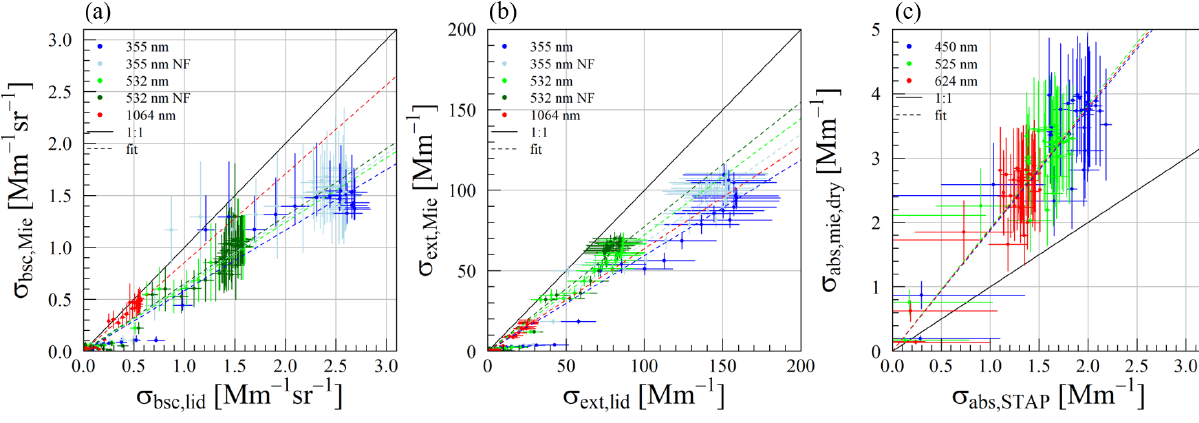
Figure 10. Corresponding to Fig. 9 for the date of 9 March 2017. Table 3. Fitting estimates with the standard error and coefficients of determination ( R 2 ) of the linear fits shown in Figs. 9 and 10. The abbreviation NF indicates the near-field channel of the